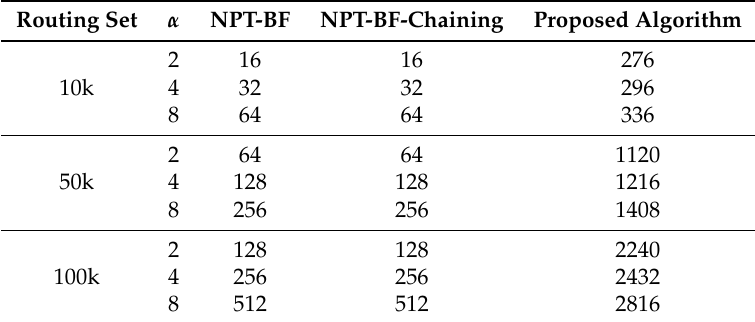
Table 3. Comparison of on-chip memory requirements (KB).